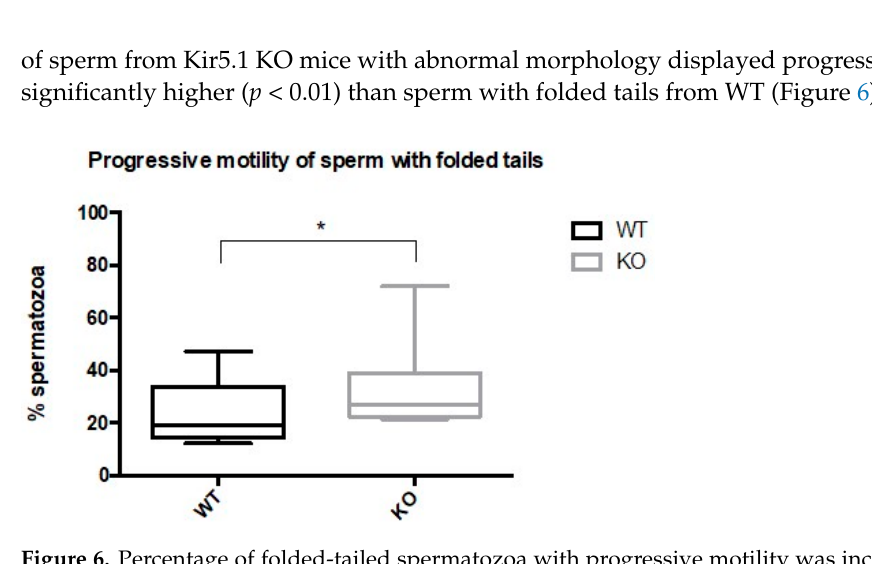
Figure 6. Percentage of folded-tailed spermatozoa with progressive motility was increased in Kir 5.1 KO mice. Progressive motility of folded-tailed spermatozoa from WT and mutant mice was evaluated. The box plot shows the percentage of folded-tailed spermatozoa with progressive motility in WT and KO mice evaluated by bright-field microscopy (* p < 0.01).